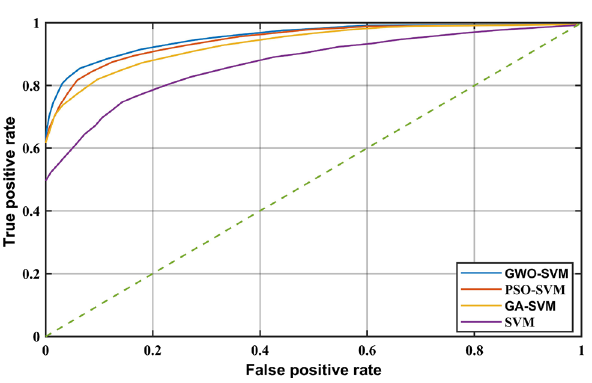
Figure 11. ROC curve of four classifiers.